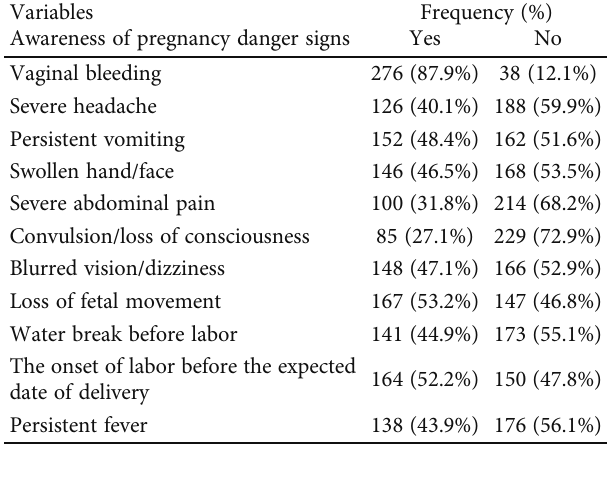
Table 3: Knowledge of pregnancy danger signs among pregnant women attending antenatal care at Jabi Tehnan District health centers in April 2021 ( n = 314 ).